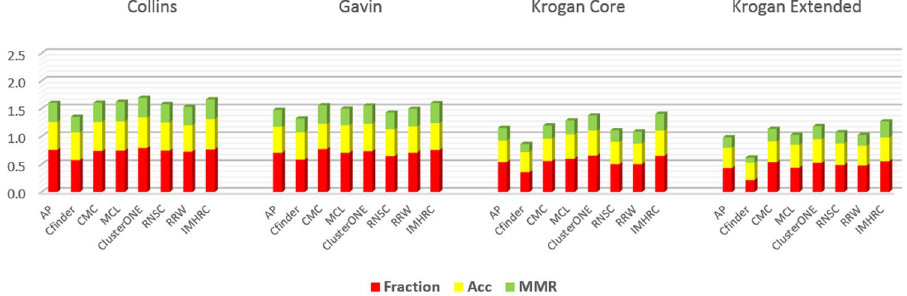
Figure 5. Modules obtained by different methods. Comparison of the total performance of all methods used in the evaluation on all datasets and using the MIPS gold standard.